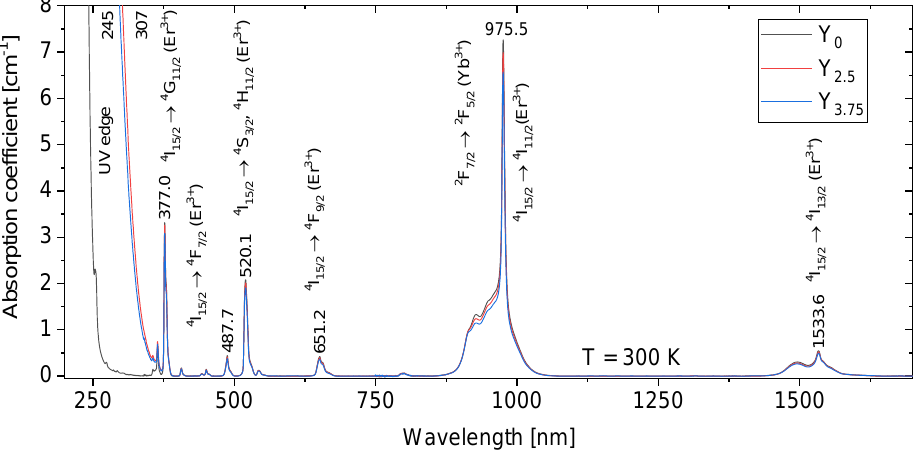
Figure 4. The absorption spectrum of the glasses.